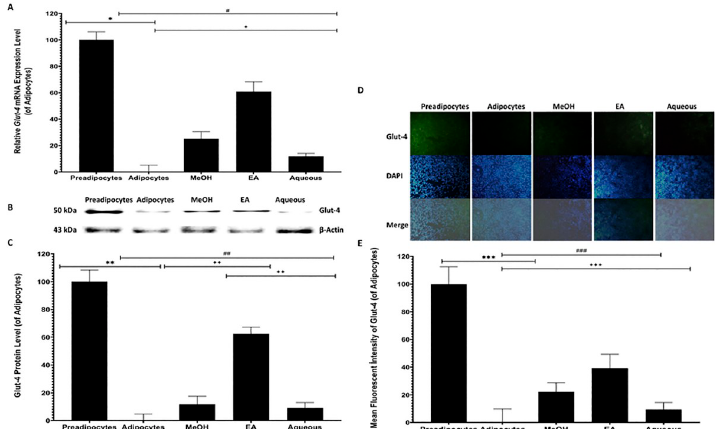
Fig 5. qRT-PCR, Western-blot, and immunofluorescence staining showing the effect of B . spergulifolius extracts on translocation and expression of Glut-4 in 3T3-L1 adipocytes. The expression of Glucose transporter-4 (Glut-4) gene, protein and intra-cellular was quantified by qRT-PCR, Western-blot and immunofluorescence staining in preadipocytes, mature adipocytes without B . spergulifolius extracts and adipocytes treated with IC 50 doses of MeOH, EA and Aqueous of B . spergulifolius extracts for 24 h. A. Glut-4 gene expression was detected using qRT-PCR at the mRNA level. Gapdh gene was used for normalization. The relative fold change analysis was conducted using the ΔΔ C T method. qRT-PCR was analysed using ΔΔ C T from three independent experiments. Data are expressed as the relative changing of the ΔΔ C T and presented as the means ± SD. B. Representative image showing Glut-4 protein (55 kDa) levels in 3T3-L1 cells by Western-blot (20 μ g/lane). C. The relative intensities of Glut-4 protein band were measured as densitometrically. Beta-Actin ( β -Actin) protein was used for normalization. Data were analysed using the ImageLab software. Densitometric analysis data was presented as the relative changing of the band intensities and the means ± SD from three independent experiments. D. The microscopic image at 10X magnification showing Glut-4 expression levels and nuclear staining in 3T3-L1 cells by immunofluorescence staining. Merged images obtained using anti-Glut-4 antibody and diamido-2-phenylindole dihydrochloride (DAPI) (Scale bar: 100 μ m) E . Three coverslips for each cell group were evaluated. Six distinct-randomly chosen regions in each coverslip were pohotographed using a microscope and relative intensities of immunofluorescence staining with anti-Glut4 antibody were quantified using ImageJ software. The immunofluorescence staining analysis data are presented as the relative changing of the fluorescein signal intensities and the means ± SD. To analyze statistical was used Student’s t-test (two-tailed). � p < 0.05, �� p < 0.0001, and ��� p < 0.0001, significantly different from Preadipocytes. # p < 0.05, ## p < 0.05 and ### p < 0.05, significantly different from mature 3T3-L1 Adipocytes. ✦ p < 0.05, ✦✦ p < 0.05, and ✦✦✦ p < 0.05, significantly different from treatment